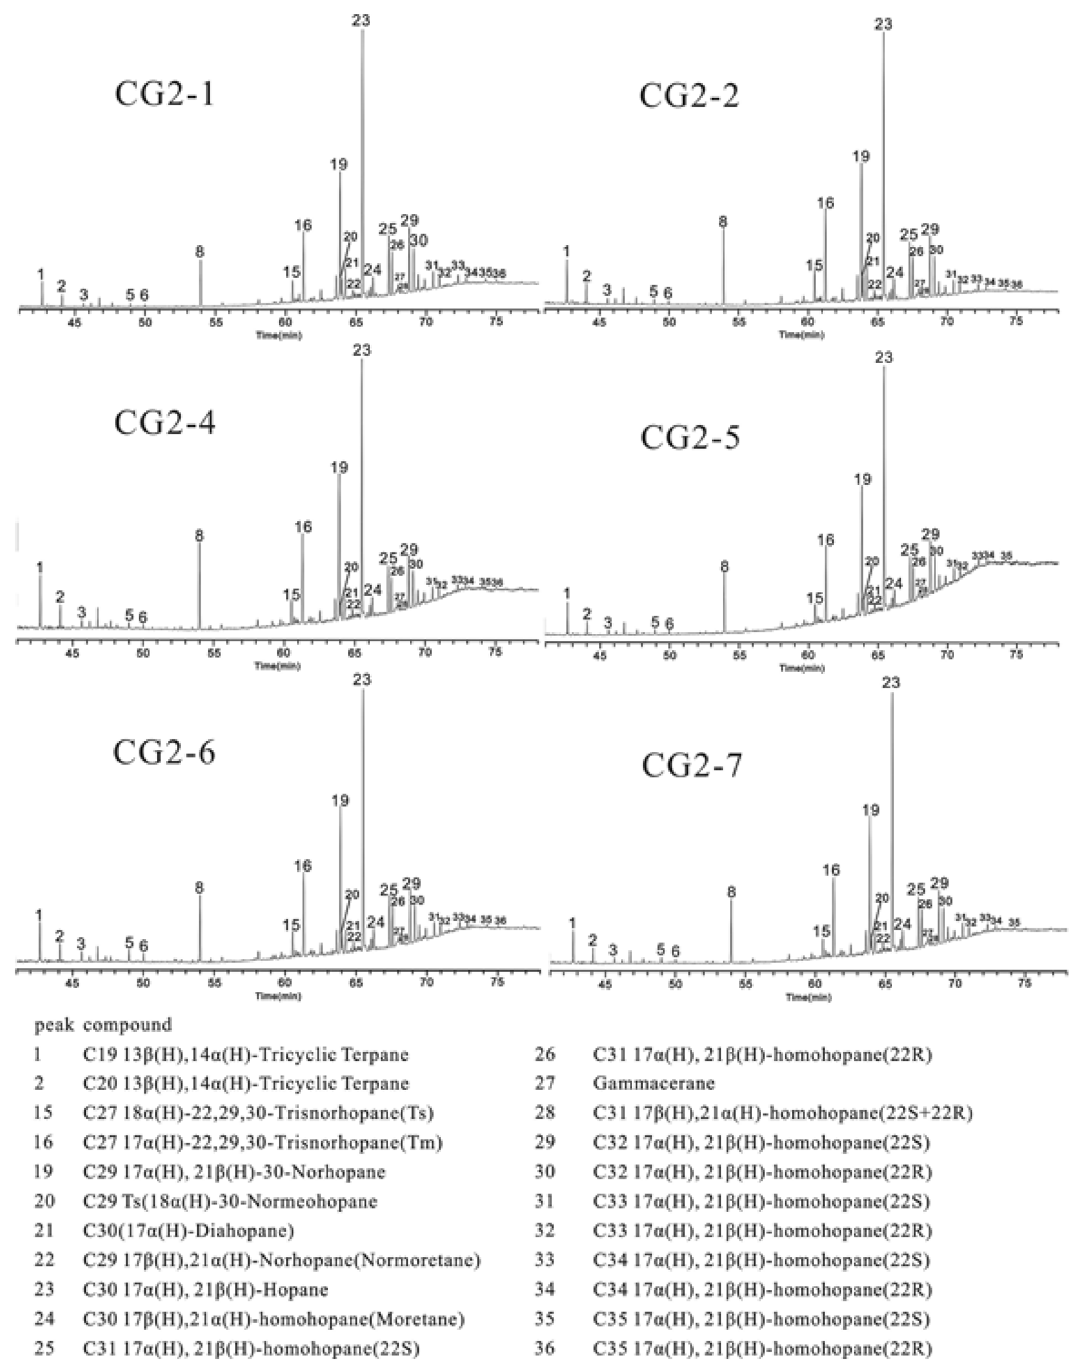
Fig. 7 The m/z 191 mass fragmentograms of saturated hydrocarbon fractions for samples